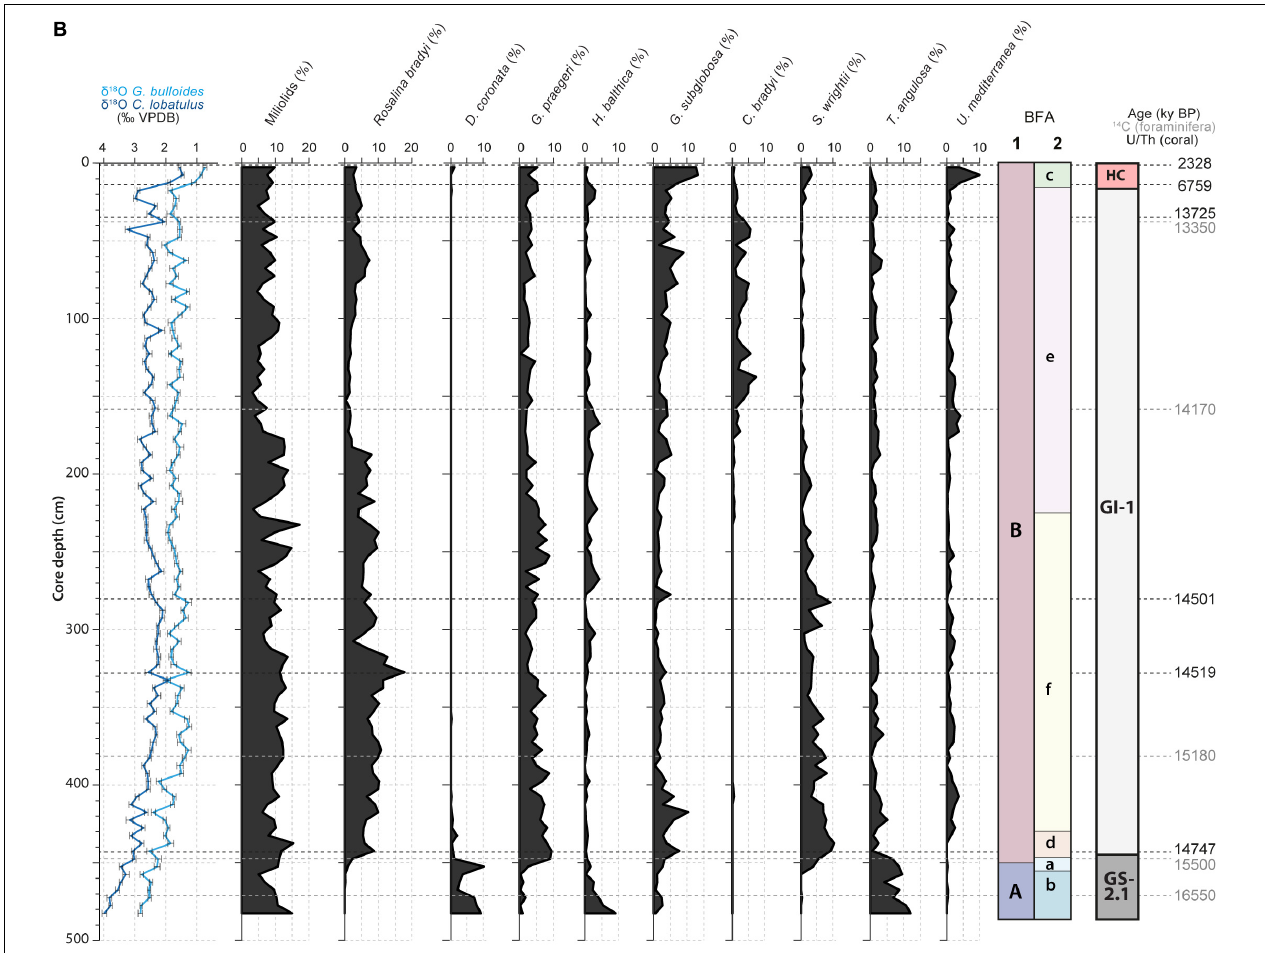
FIGURE 3 | (A) Benthic foraminiferal Shannon diversity and distribution of the main benthic foraminifera species (expressed as percentages). The benthic foraminiferal assemblages (BFA) identified at 47% similarity and at 62% similarity thanks to the hierarchical cluster analysis ( Figure 4 ) are illustrated. The stratigraphic column defined in Figure 2 , the G. bulloides planktonic and C. lobatulus benthic δ 18 O records and the U/Th coral and calibrated median 14 C benthic foraminifera ages are further indicated. (B) Distribution of the main benthic foraminifera species (expressed as percentages). The benthic foraminiferal assemblages (BFA) identified at 47% similarity and at 62% similarity thanks to the hierarchical cluster analysis ( Figure 4 ) are illustrated. The stratigraphic column defined in Figure 2 , the G. bulloides planktonic and C. lobatulus benthic δ 18 O records and the U/Th coral and calibrated median 14 C benthic foraminifera ages are further